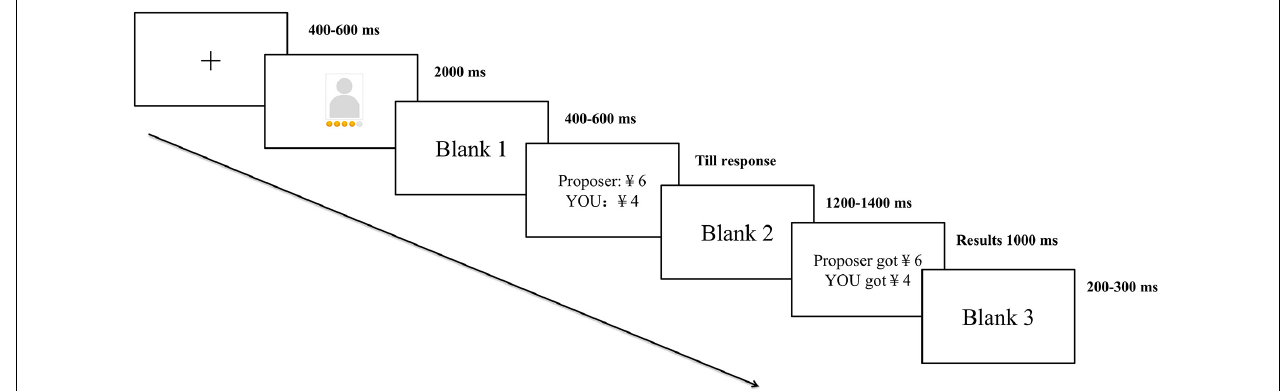
FIGURE 1 | Sequence of events in a single